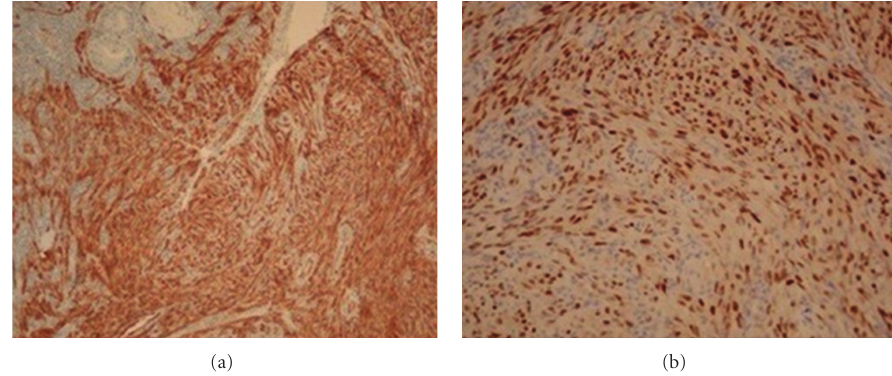
Figure 3: Immunohistochemical analysis showing the positivity for CD31 and CD34 (a) and the strong immunoreactivity for HHV-8 in the nuclei